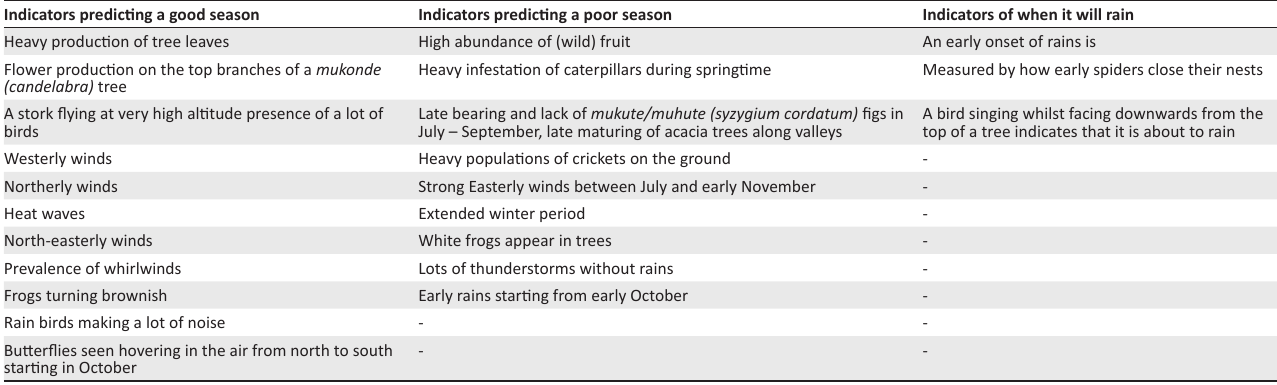
TABLE 2: Selected indigenous rainfall predictions commonly employed in Zimbabwe. Indicators predicting a good season Indicators predicting a poor